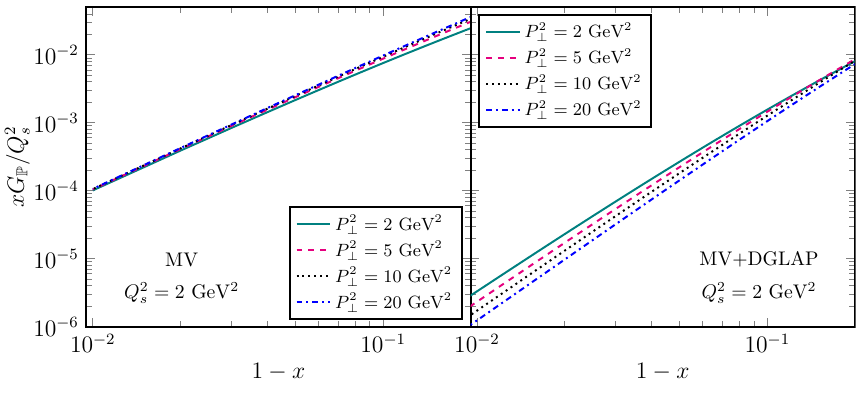
Figure 14 . Logarithmic plot of a dimensionless Pomeron gluon distribution obtained by dividing with Q 2 and by omitting a factor S ⊥ ( N 2 − 1) / 4 π 3 when x → 1 . Left panel: tree-level result (with s c T g ( R ) given by the MV model) as a function of x , for various values of P 2 . Right panel: the same ⊥ as obtained from the solution to the DGLAP equation (5.24) with the source term evaluated with the MV